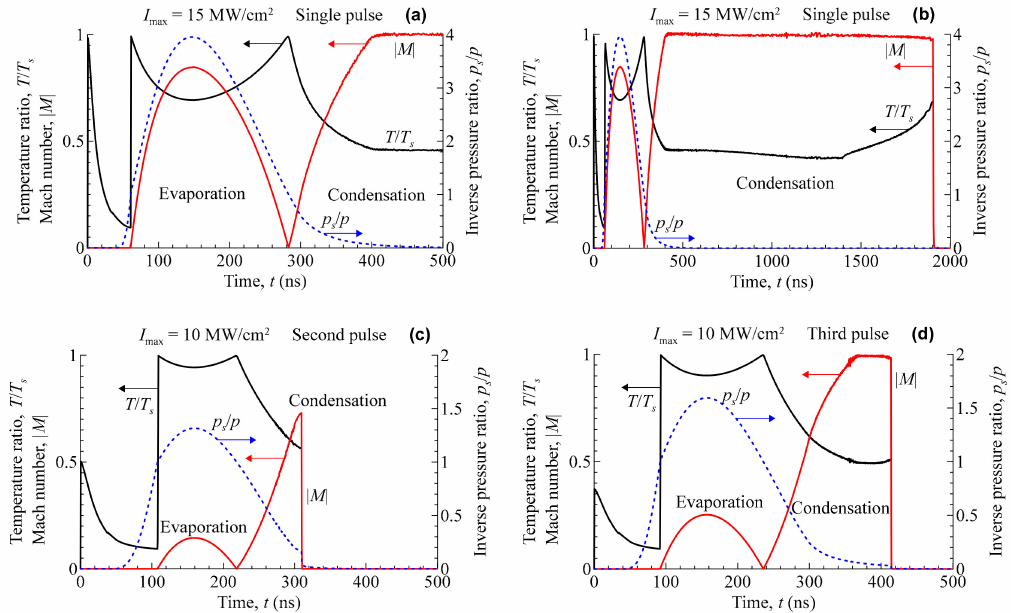
Figure 8. Parameters of the Knudsen layer at evaporation / condensation at di ff erent regimes of laser processing: single pulse processing ( a , b ); multipulse processing: ( c , d ). The arrow near each curve points to the corresponding axis: temperature ratio (black curves); Mach number (red curves); inverse pressure ratio (dashed blue curves).